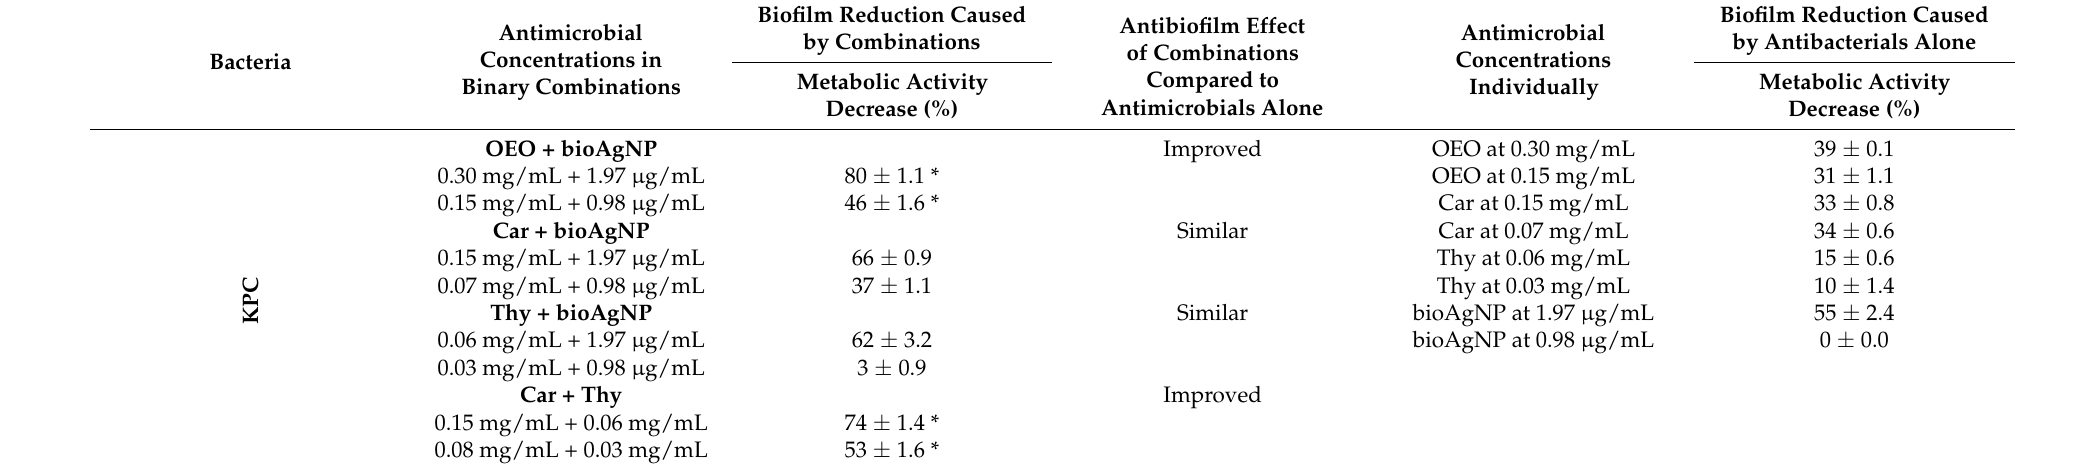
Table 6. Antibiofilm effect, which is shown in terms of metabolic activity reduction of oregano derivatives and biological silver nanoparticles (bioAgNP) compared to both antimicrobials individually against and KPC-producing Klebsiella pneumoniae (KPC) biofilms growth in microtiter plates, which were evaluated at preformed biofilm